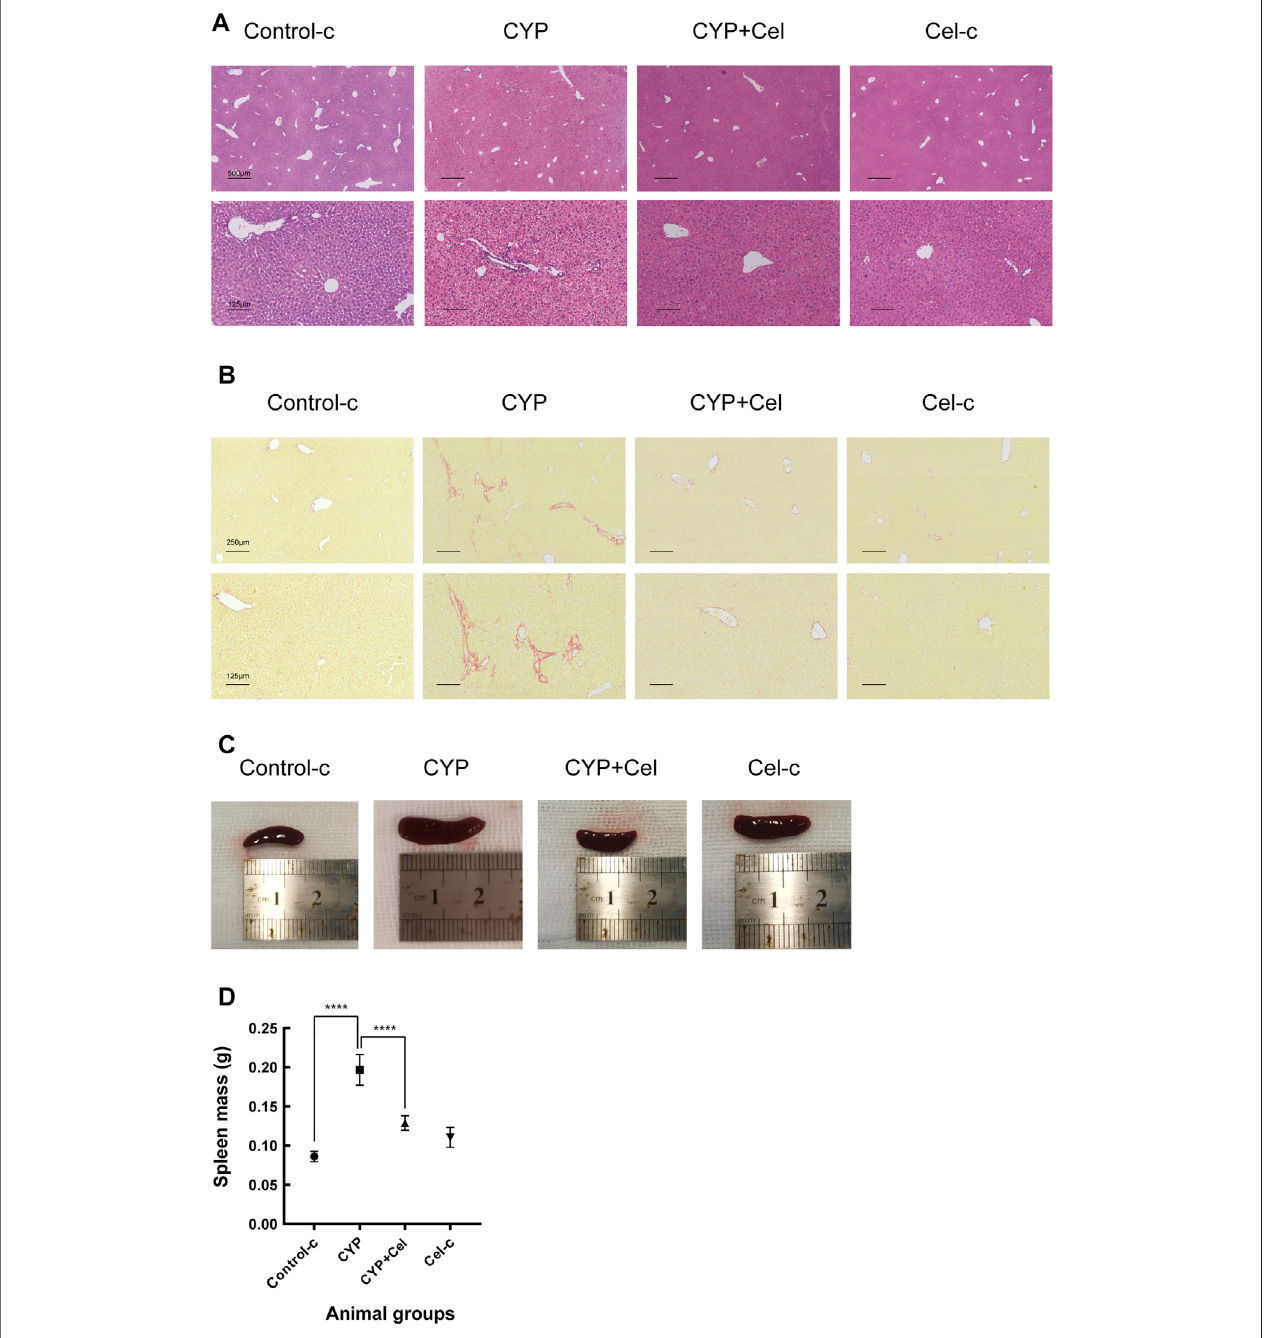
FIGURE8| In fl ammatory in fi ltration and liverinjuryofexperimental AIH models were alleviated incelastroltreatedmice. Representativephotographs ofHE stained (A) and Sirius Red stained (B) liver sections. (C,D) Differential sizes of the spleens from each group of animals, ****p < 0 . 0001 .